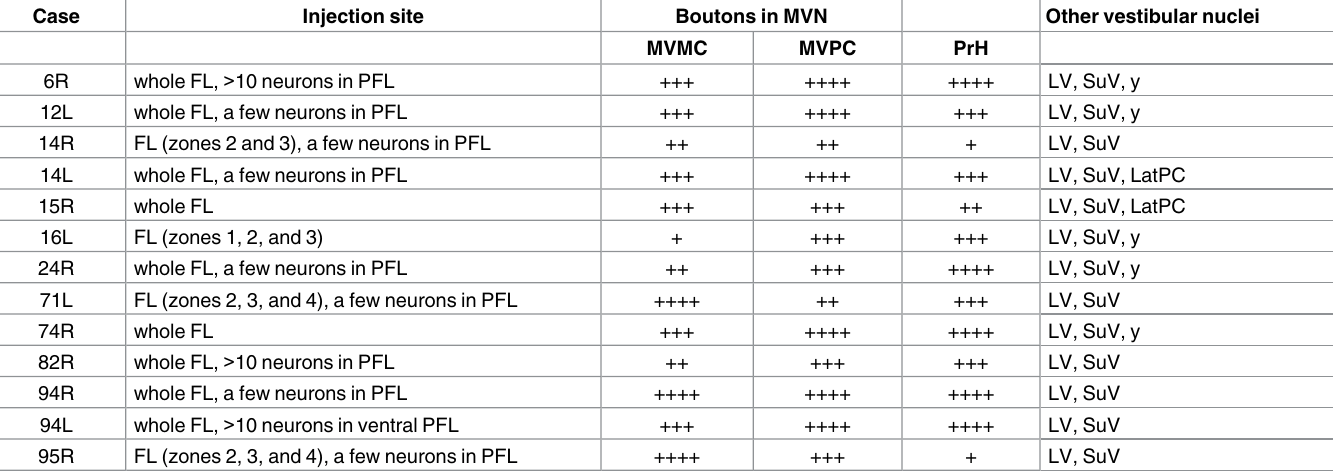
Density of labeled boutons for each subregion were evaluated for two brain sections for each case (approximately 6.00 mm and -6.36 mm from bregma) as +, 0–50 boutons; ++, 50–100 boutons; +++, 100–200 boutons; ++++, > 200 boutons. FL, flocculus; LatPC, parvocellular region of lateral cerebellar nucleus; LV, lateral vestibular nucleus; MVN, medial vestibular nucleus; MVMC, magnocellular MVN; MVPC, parvocellular MVN; PFL, paraflocculus; PrH, prepositus hypoglossi nucleus; SuV, superior vestibular nucleus; y, group y. Injection sites in FL are shown as zones 1~4, according to [12], in which FL was divided to four sagittal zones in the lateral-ventral to medial-dorsal direction. Labeled neurons in PFL were counted at the level of the injection